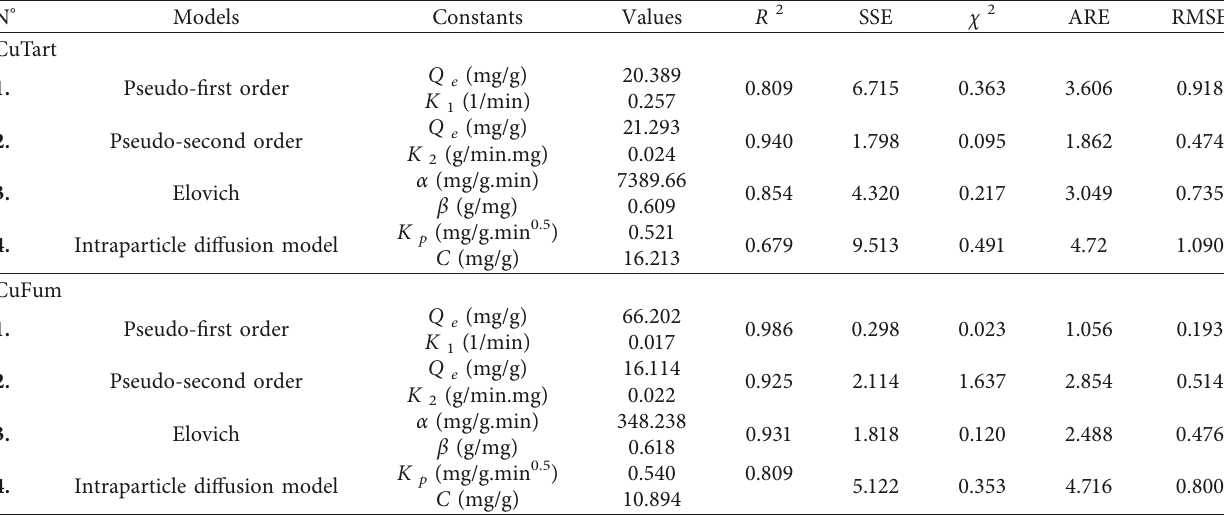
Table 3: Kinetic data obtained by non-linear fitting analysis.